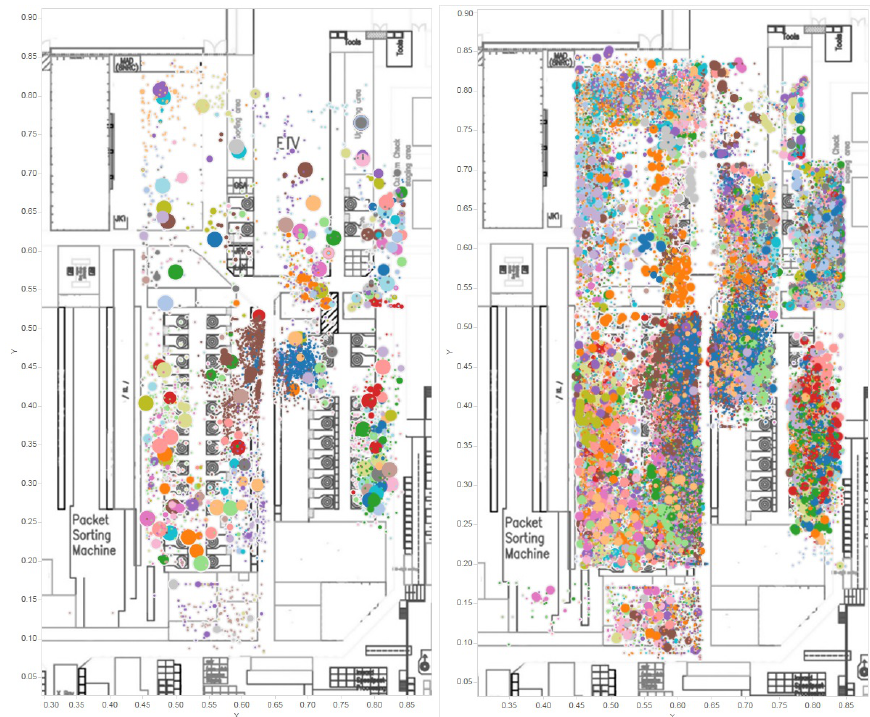
Figure 8. Offline visualization of cart movements. The locations of the carts: for a selected hour ( left ); and for a selected day ( right ). The different colors represent different carts. The circle size is directly proportional to the total duration that the cart was staying at the same location